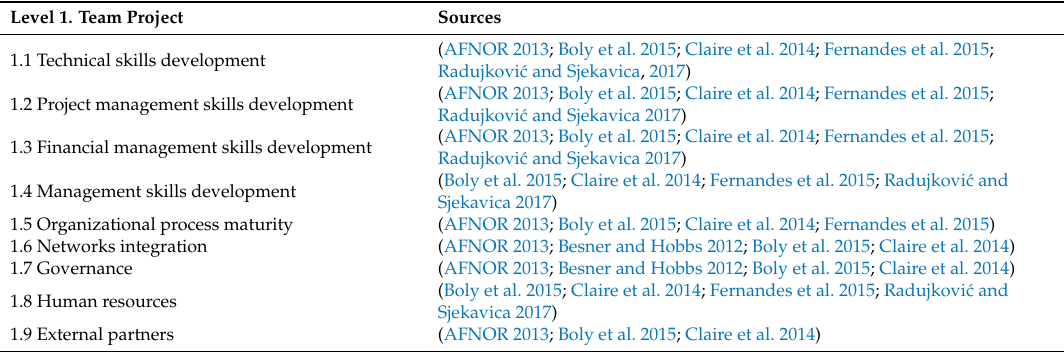
Table 2. Project management practices